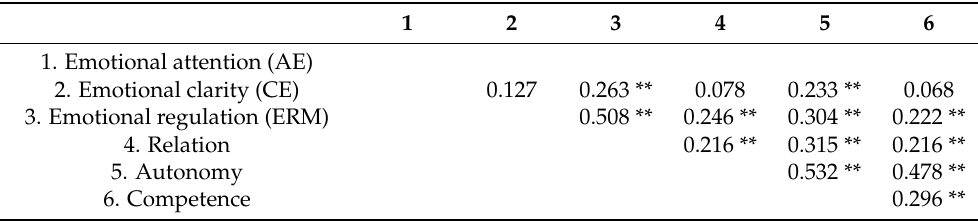
Table 2. Preliminary